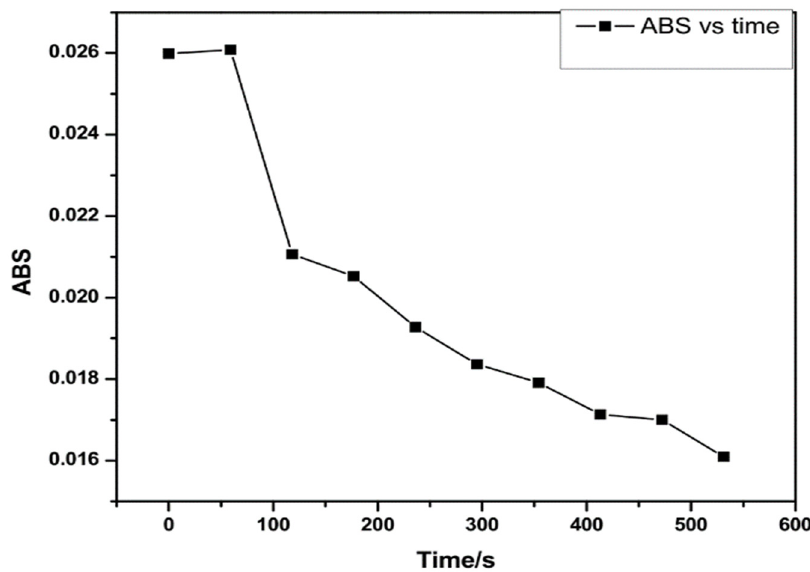
Figure 9. A plot of absorbance data versus time for NONOate decomposition in 0.1 M PBS (PH 7.2) under ambient conditions.